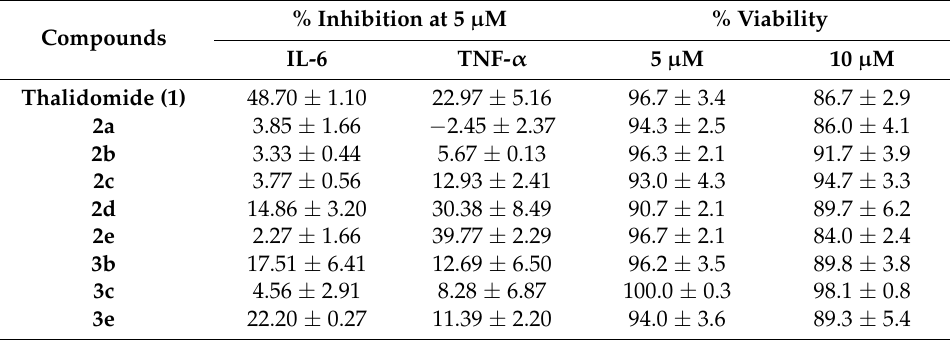
Table 1. Preliminary anti-psoriasis activity and cytotoxicities of thalidomide derivatives.